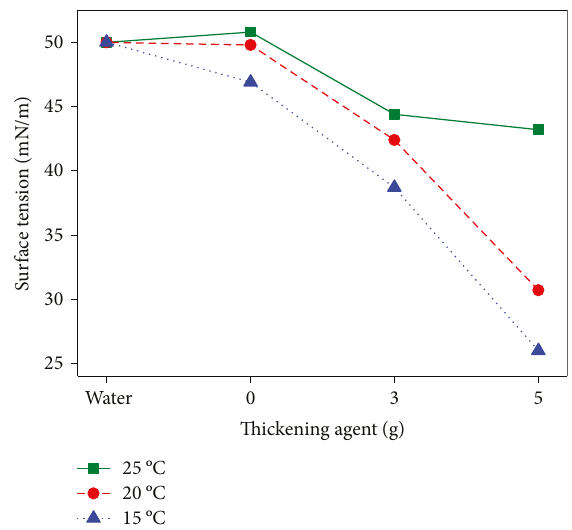
Figure 8: Surface tension of three samples within three di ff erent